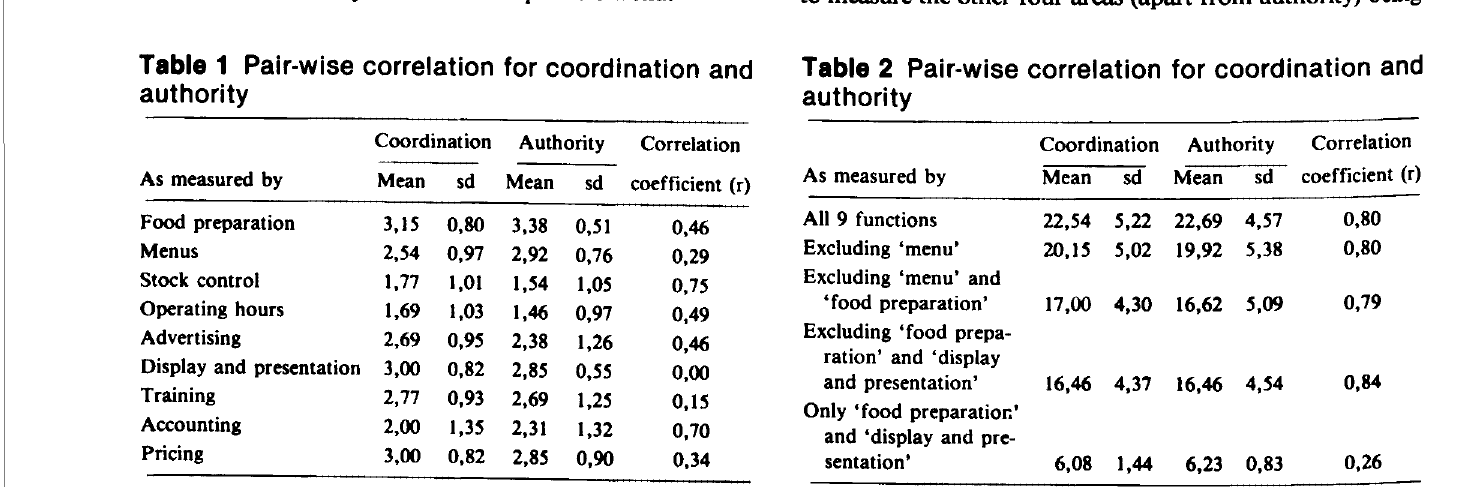
Table 1 Pair-wise correlation for coordination and